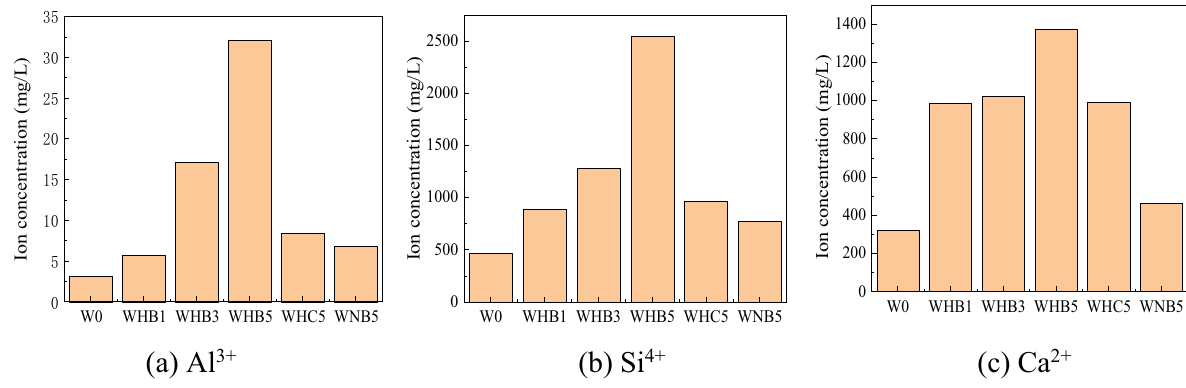
Fig. 9 Ion release concentration of iron tailings in deionized